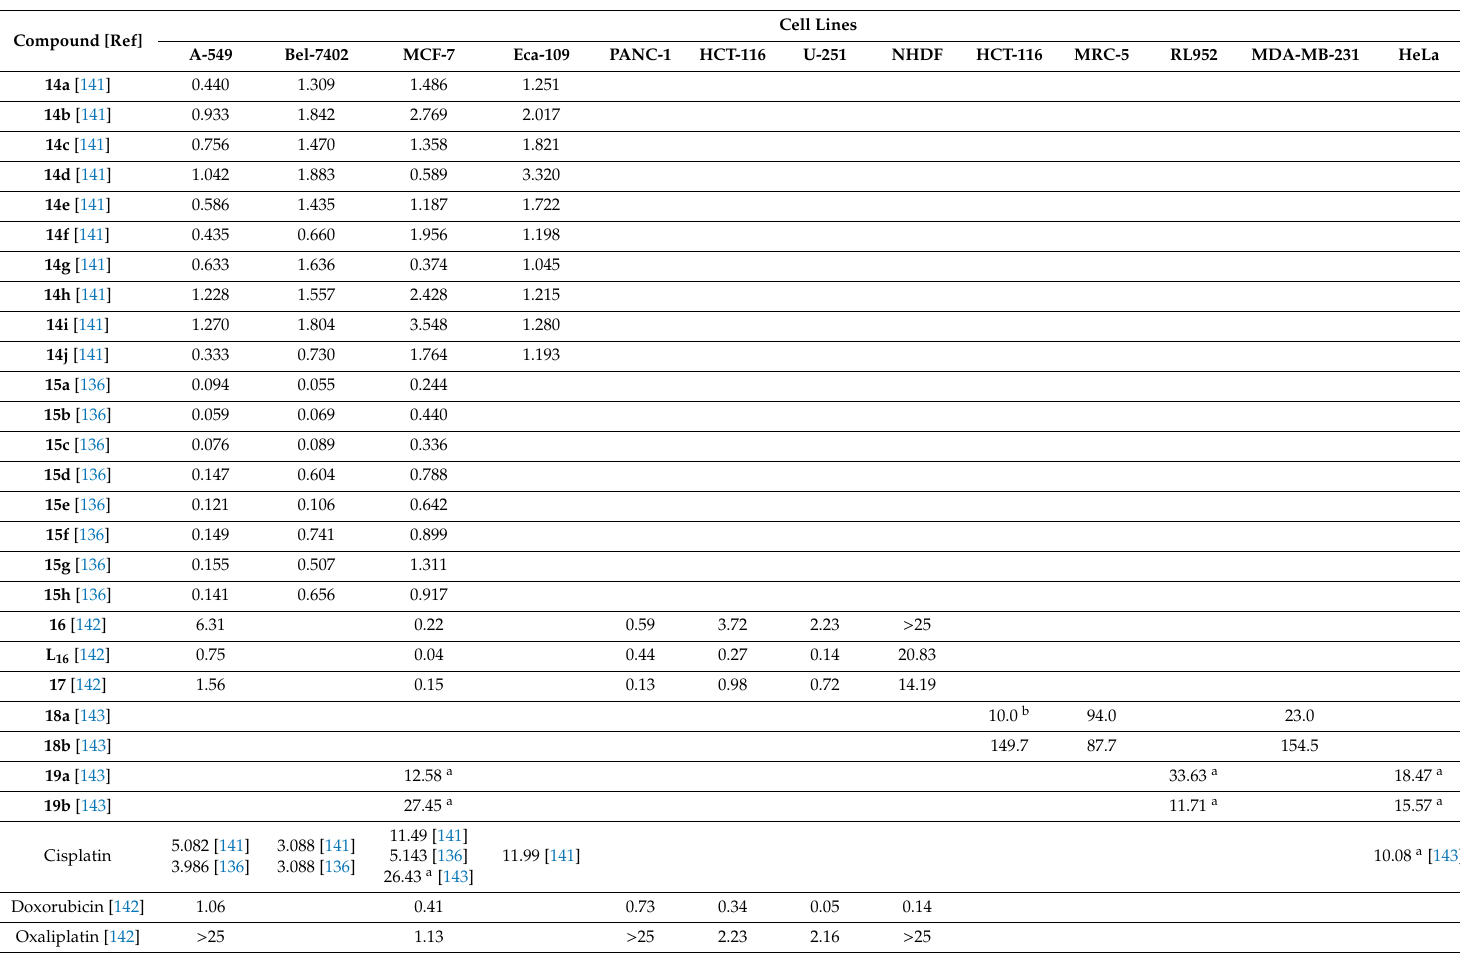
Table 4. IC 50 values ( µ M) for terpyridine complexes 14 – 19 , the free ligand L 16 and the reference compounds cisplatin, oxaliplatin and doxorubicin against di ff erent tumor and normal (NHDF and MRC-5) cell lines, after an incubation time of 72 h. Compound